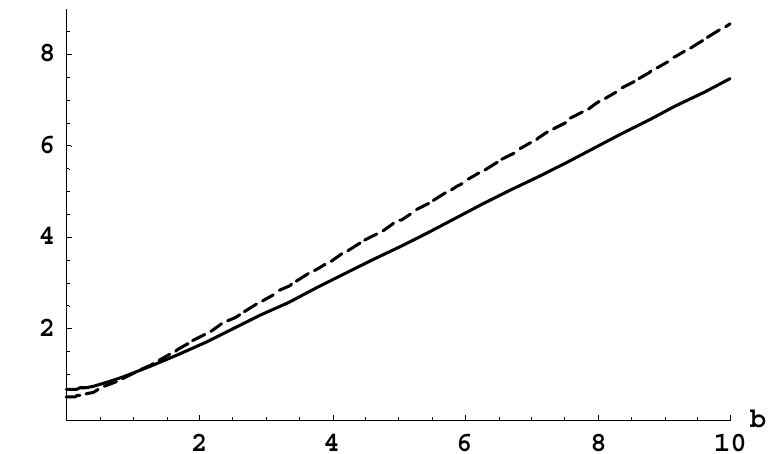
Figure 1. The ratio of positions ∆ ω dip ( α ) / ∆ ω dip ( β ) in the pair of the L-dips corresponding to ( n ’ + n ”) α = 0, ( n ’+ n ”) β = − 1, versus the scaled (dimensionless) magnetic field b (defined by Equation (12)) for the Balmer-alpha line (solid curve) and for the Balmer-beta line (dashed curve).